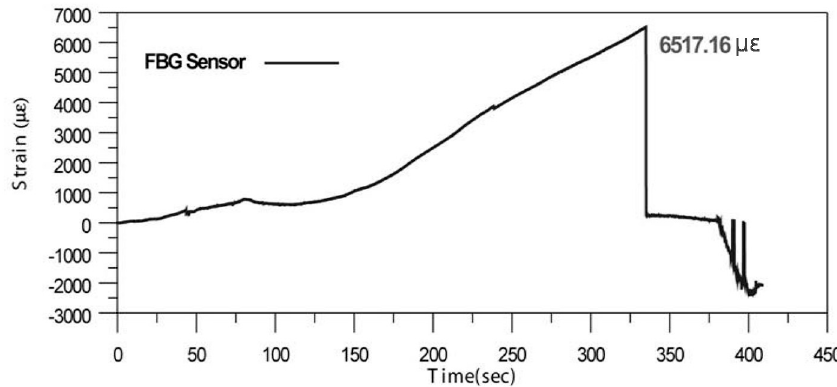
Figure 1. Strain measured using an FBG sensor embedded in the seven-wire steel strands [21].